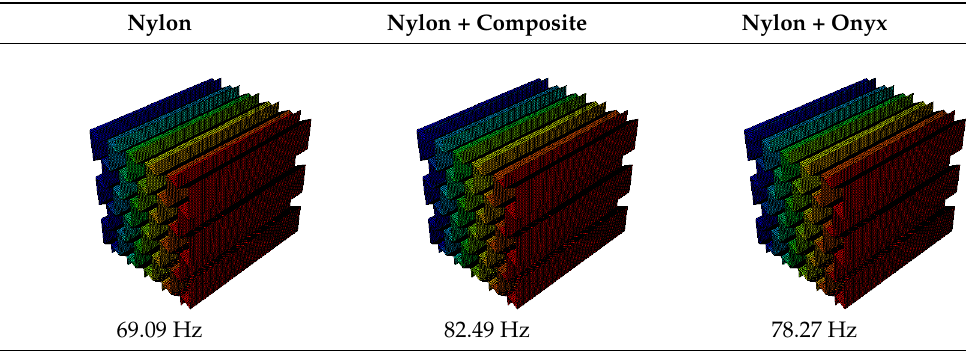
Table 14. First five paired mode shapes of Re-entrant Lattice Structure with right and left sides